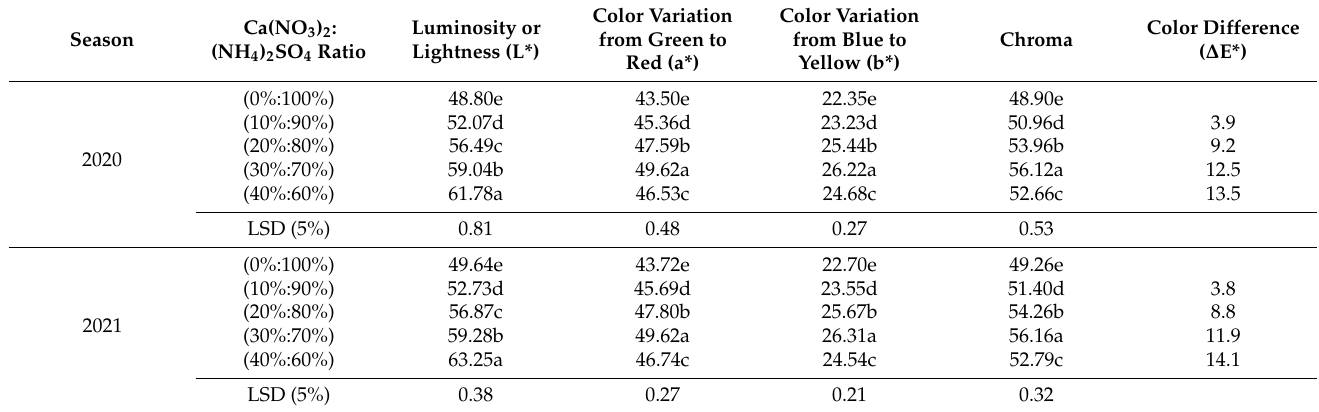
Table 4. Impact of Ca(NO 3 ) 2 :(NH 4 ) 2 SO 4 ratios on peel color factors of the pomegranate fruits of cv. ‘Wonderful’ in 2020 and 2021 seasons.